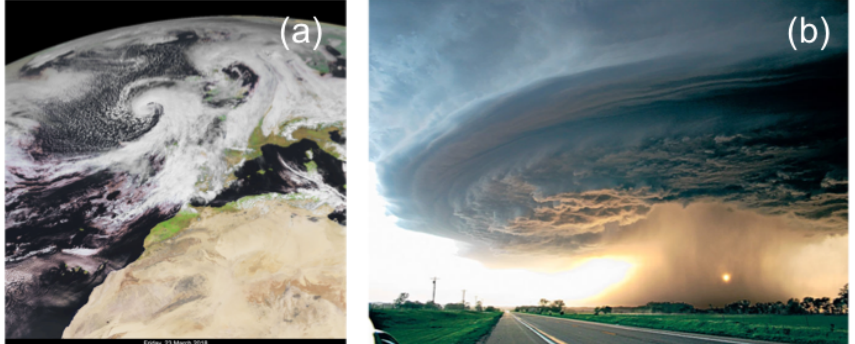
Figure 1. Synoptic extra-tropical cyclone ( a , © 2018 EUMETSAT) and mesoscale thunderstorm downburst ( b , photo by Mike Hollingshead, www.extremeinstability.com, last access: 20 July 2018).